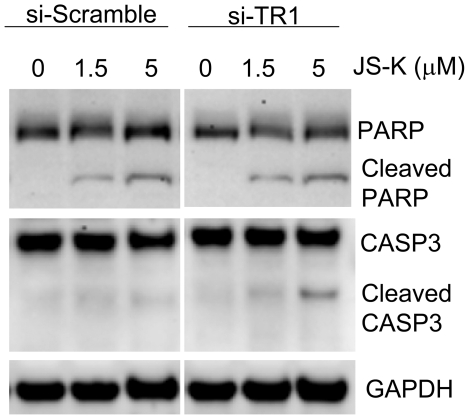
Immunoblot evaluation of cleaved PARP and caspase 3.RKO cells treated with vehicle, 1.5, or 5 µM JS-K for 24 hrs. Protein was separated by SDS-PAGE and detected with immunoblot analysis. A dose-dependent increase in cleaved PARP and caspase 3 (CASP3) was observed with more cleaved material in the TR1 knockdown. GAPDH was evaluated as a loading control.